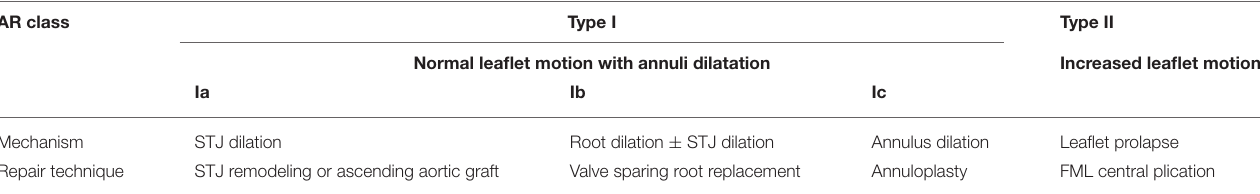
TABLE 6 | AV repair techniques based on the classification of AR with description of disease